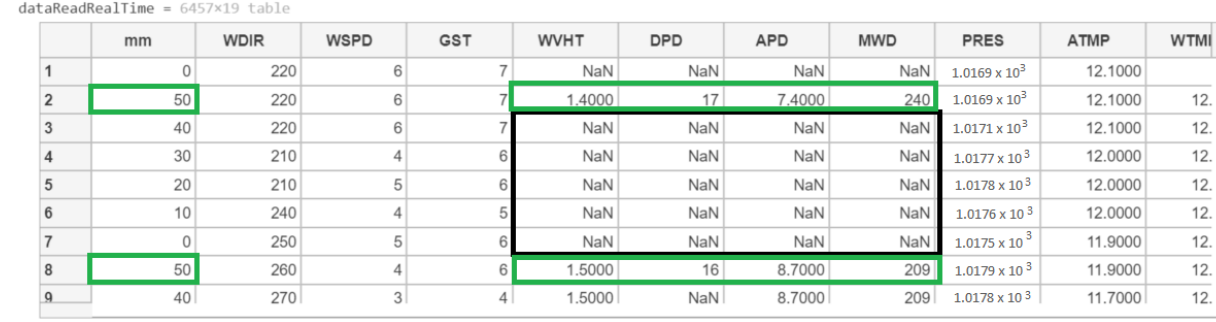
Figure 2. Sample of historical data from the Santa Maria buoy. In Figure 3, real-time data from 2020 are presented.